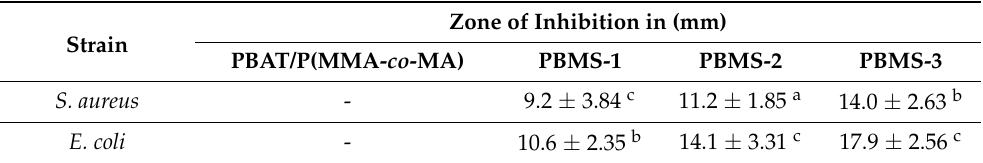
Table 4. Antimicrobial activity test values of the PBAT/P(MMA- co -MA) and PBAT/P(MMA- co -MA)– SiO 2 composites against S. aureus and E. coli